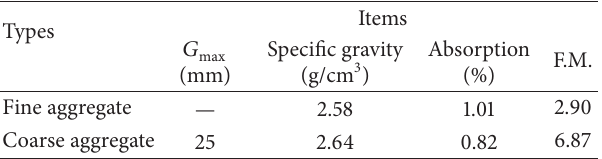
Table 2: Physical properties of